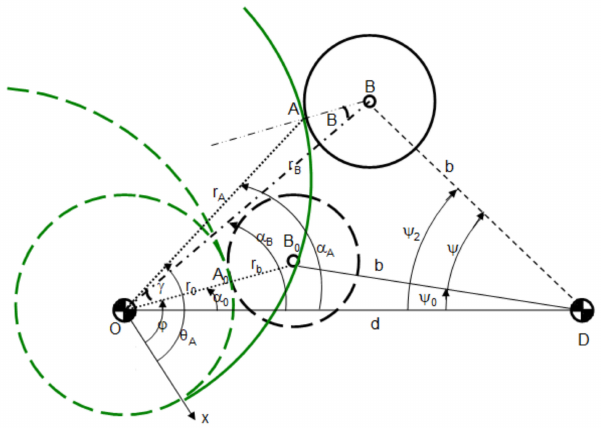
Figure 6. A mechanism with rotating cam and rotating adept with roller.